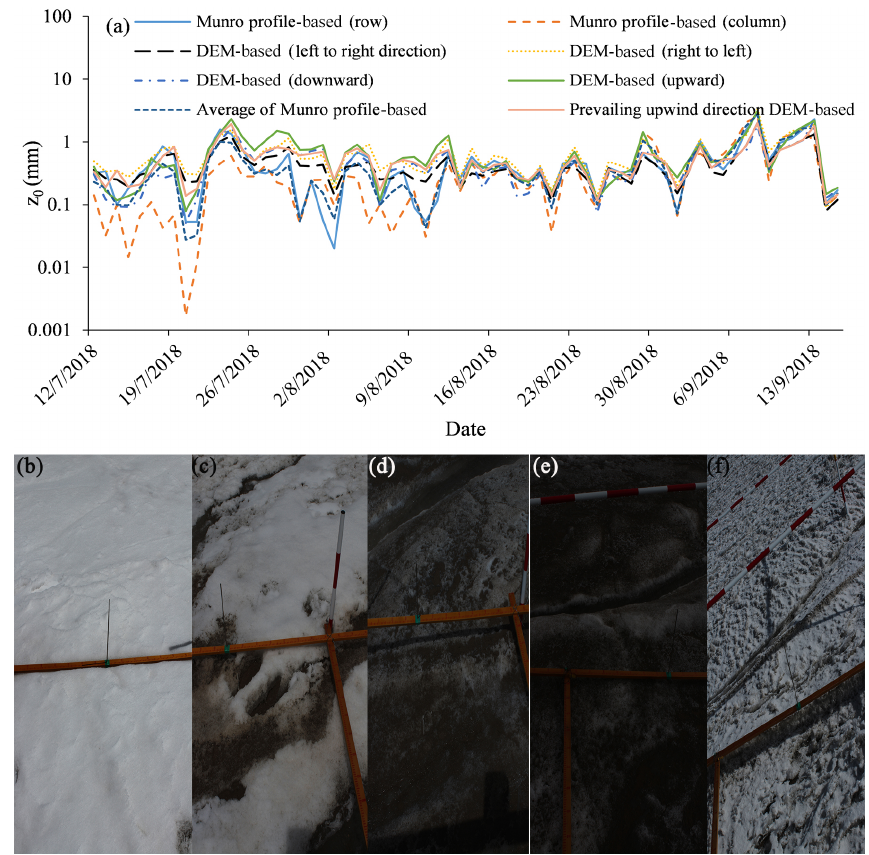
Figure 5. (a) Variation in glacier surface aerodynamic roughness over time at the automatic observation site for the DEM-based and Munro (1989) profile-based approaches. Panel (b) shows a snow-covered surface on 13 July. Panel (c) shows a partially snow-covered surface on 23 July with cryoconite holes. Panels (d) and (e) show a smooth ice surface on 1 and 30 August. Panel (f) shows a rough ice surface on 13